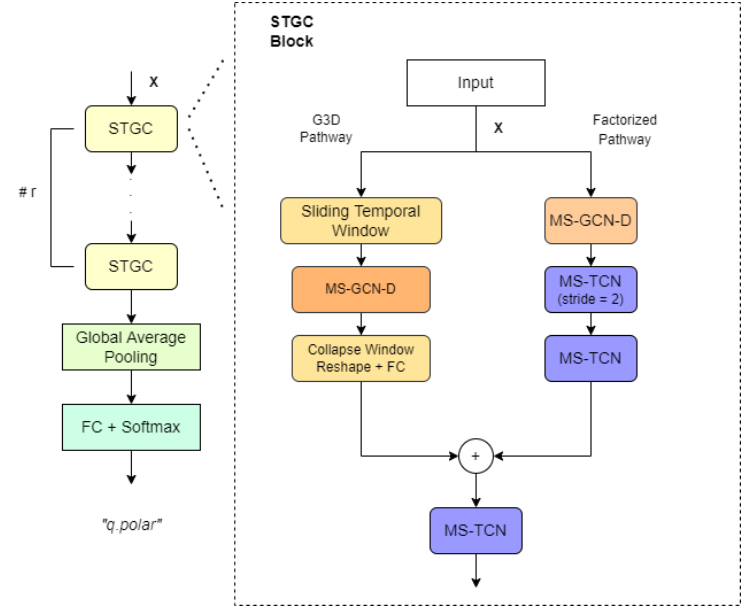
Figure 8. Overview of MSG-3D architecture. “TCN” and “GCN” denote temporal and graph convo- lutional blocks, and prefix “MS-” and suffix “-D” denote multi-scale and disentangled